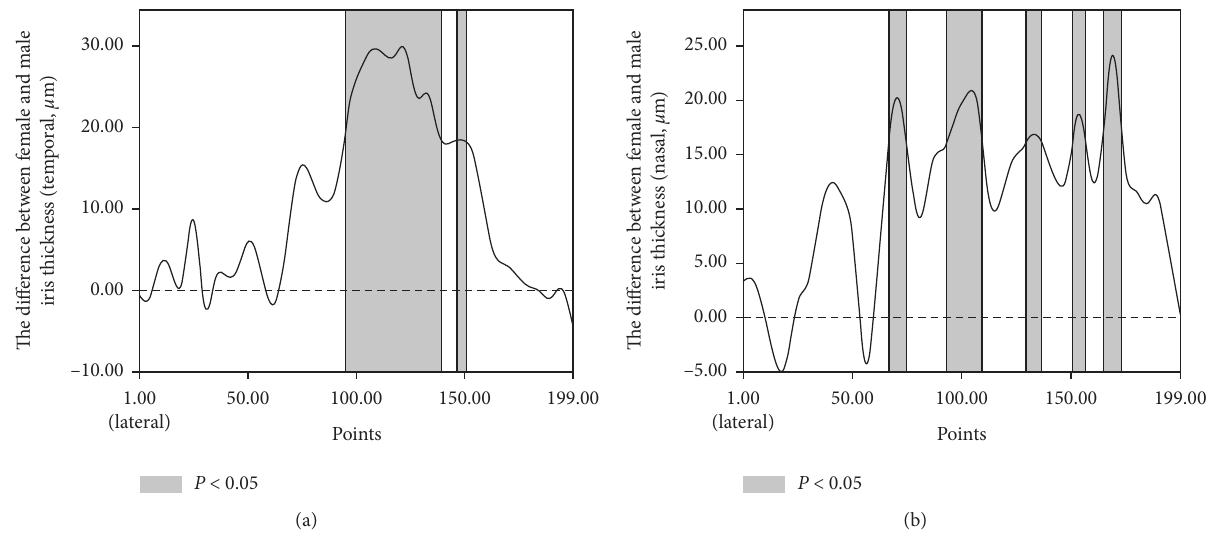
Figure 4: Iris thickness differences between females and males at the temporal (a) and nasal sides (b). Filled: the difference was statistically significant ( P <